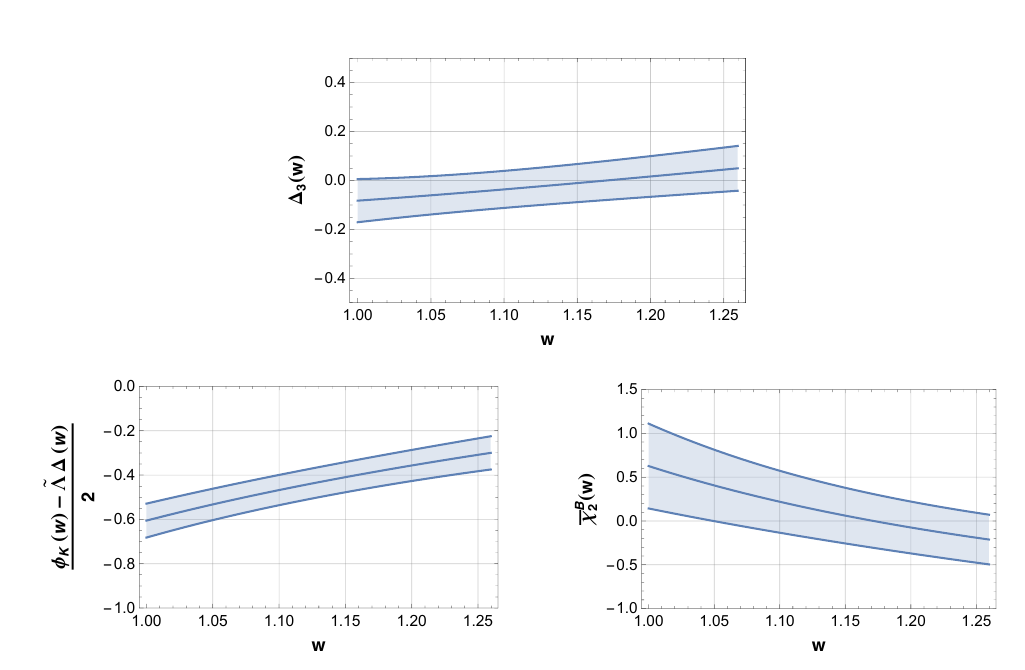
Figure 1 . B c → J/ψ form factors h V , h A for V, A . 1 , A 2 , A 0